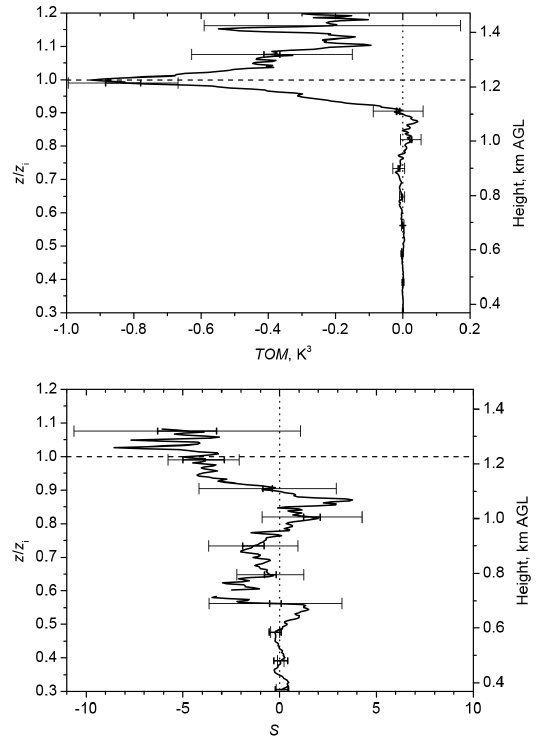
Figure 10. Same as Fig. 9 but profiles of the third-order moment (TOM) and the skewness S . Error bars show the noise errors (thin error bars) and the sampling errors (thick error bars). The mean CBL height z i of 1230m (dashed line) was used for the relative height scale z/z i . The dotted vertical line marks zero skewness. Skewness data around 0.6 and above 1.1 z/z i were omitted because the data were too noisy here due to variances close to